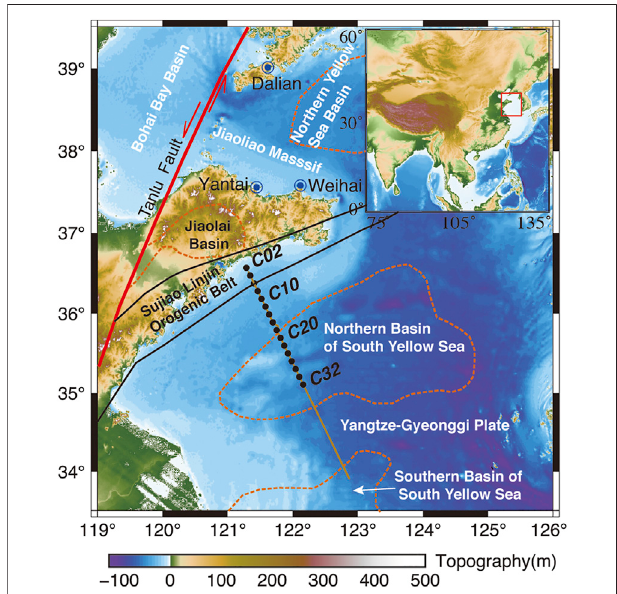
FIGURE 1 | Bathymetry/topography of OBS survey line in the Yellow Sea. The line denotes the shot pro fi le, and the black circles denote the OBS deployment